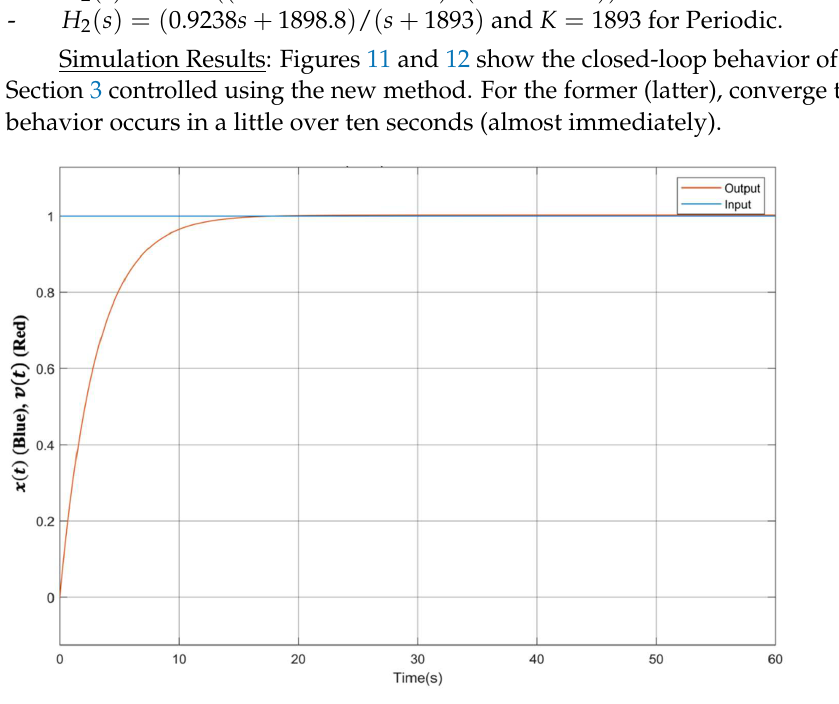
Figure 10. Response to the Periodic Input 𝒗(𝒕) = 𝐬𝐢𝐧𝒕 + 𝐬𝐢𝐧𝟑𝒕 with Technique 4.